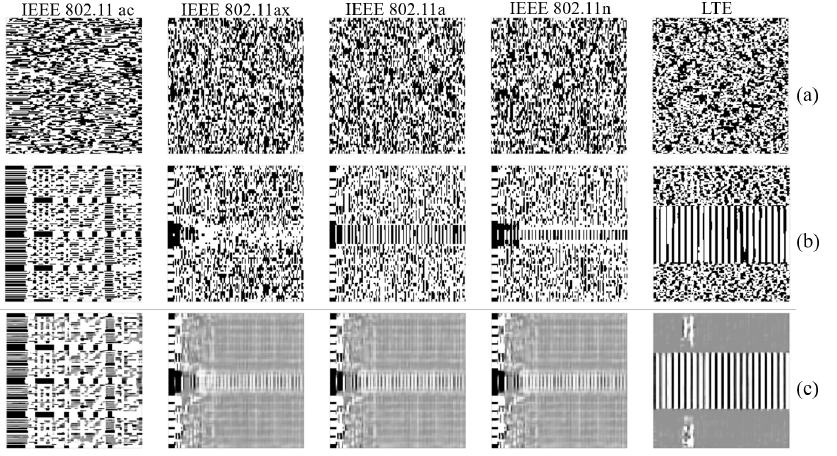
Figure 6. The spectrograms of five unlicensed radio signal for noise scenario 1 with SNR 0 dB. Shown above: ( a ) the noisy spectrograms, ( b ) the clean spectrograms, and ( c ) the decoded